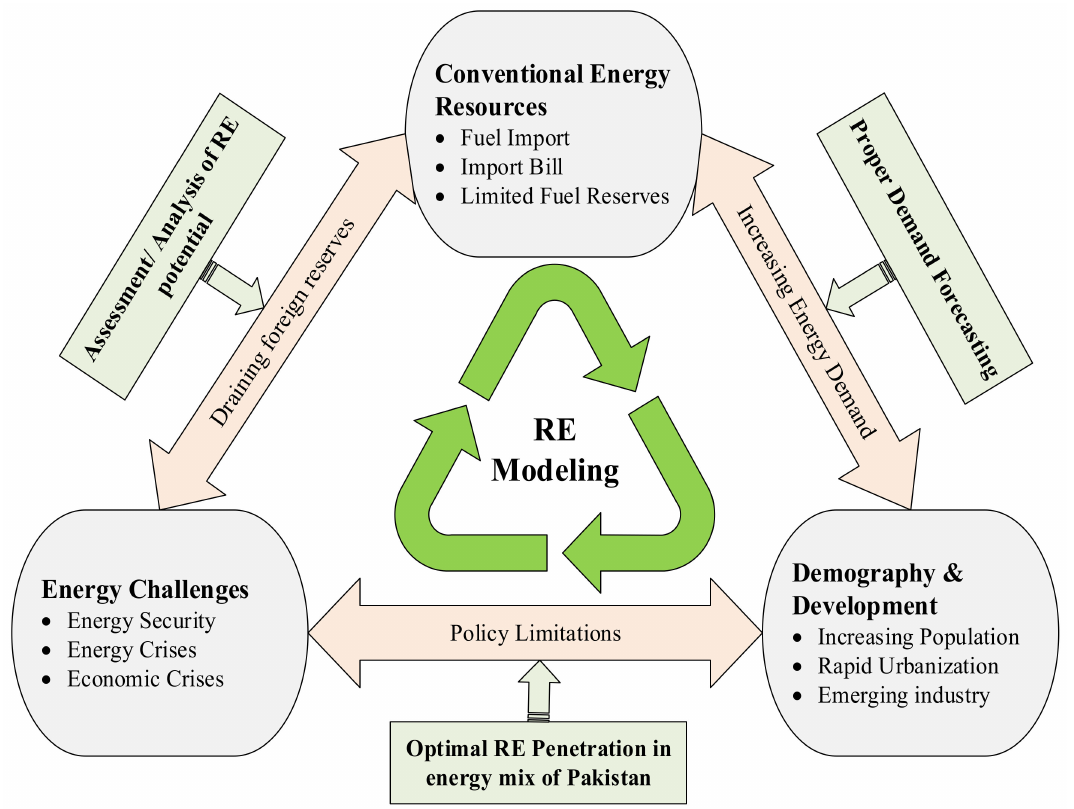
Figure 14. Analysis of research issues and knowledge